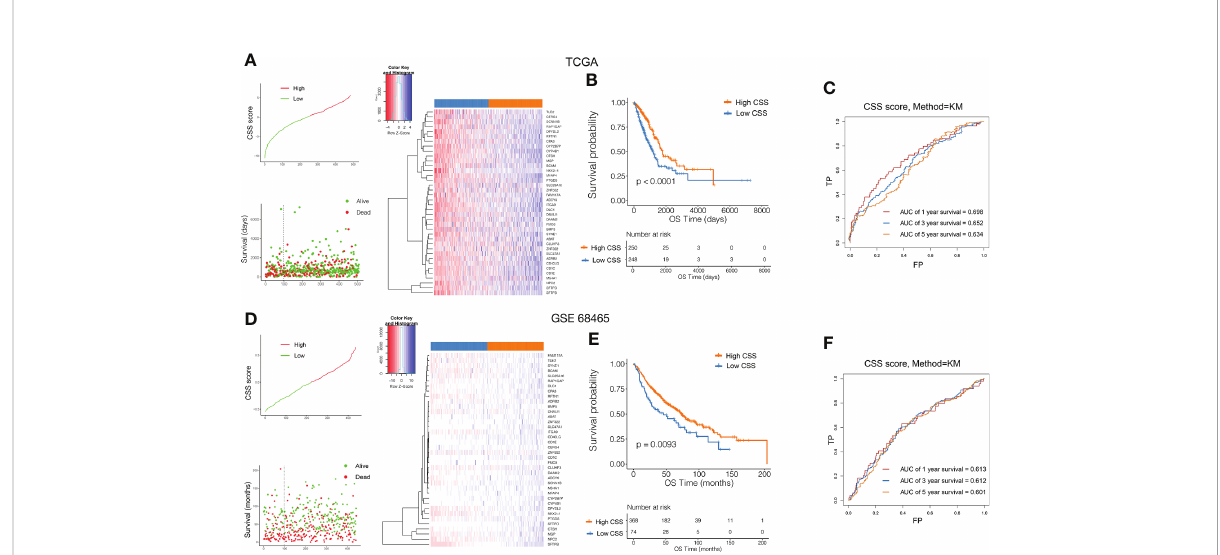
FIGURE 5 Validation of the prognostic value of CSS in the training and testing set. Ranked dot and scatter plots showing the CSS value distribution and patient survival status in TCGA (A) and GEO (D) database. Heatmaps of expression levels of prognostic DEGs in high and low CSS groups. Kaplan – Meier analysis of the OS between the high and low CSS groups in TCGA (B) and GEO (E) database. ROC curves to predict the sensitivity and speci fi city of 1-, 3-, and 5-year survival according to the CSS value in TCGA (C) and GEO (F) database. ROC, receiver operating characteristic; GO, Gene Ontology; KEGG, Kyoto Encyclopedia of Genes and Genomes; CSS, cuproptosis scoring system; DEGs, differentially expressed genes; OS, overall survival.